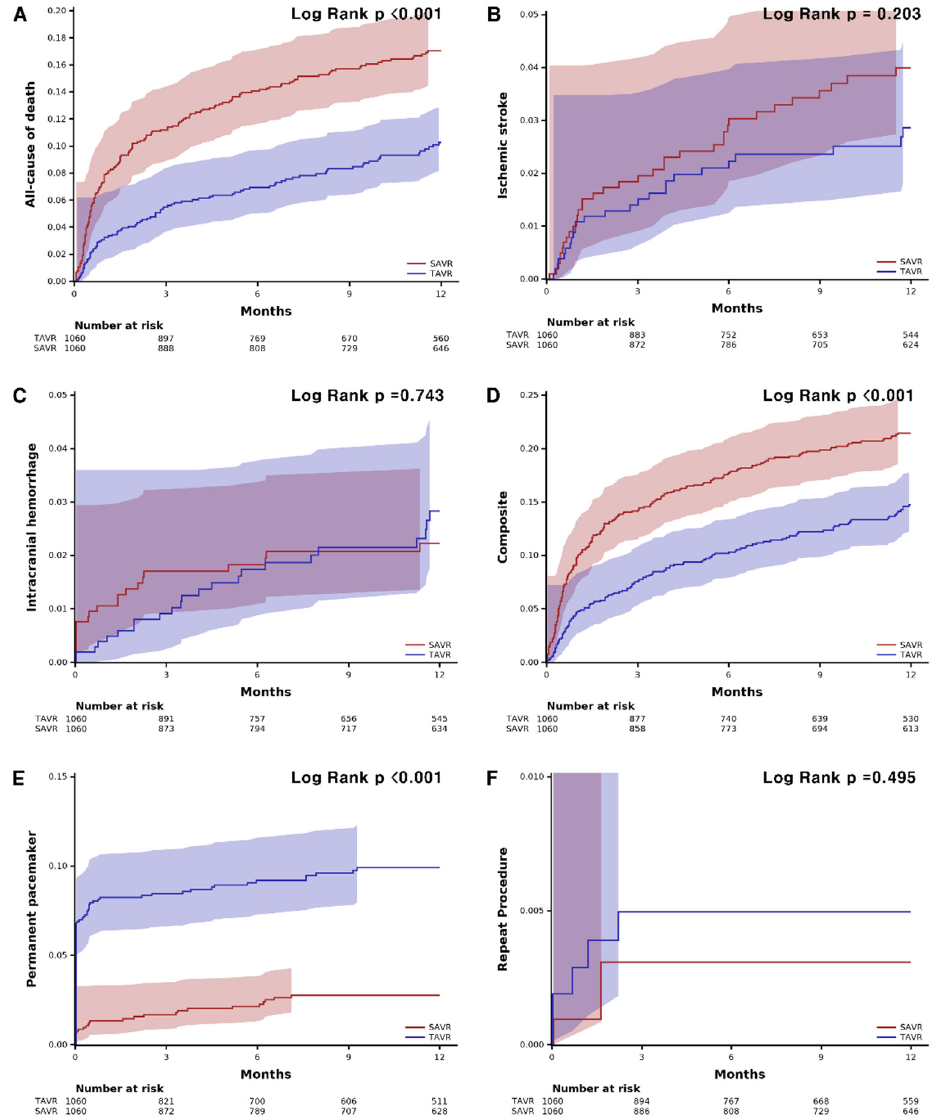
Figure 2. Kaplan–Meier curves of clinical events and safety outcomes. ( A ) all‑cause death. ( B ) is‑